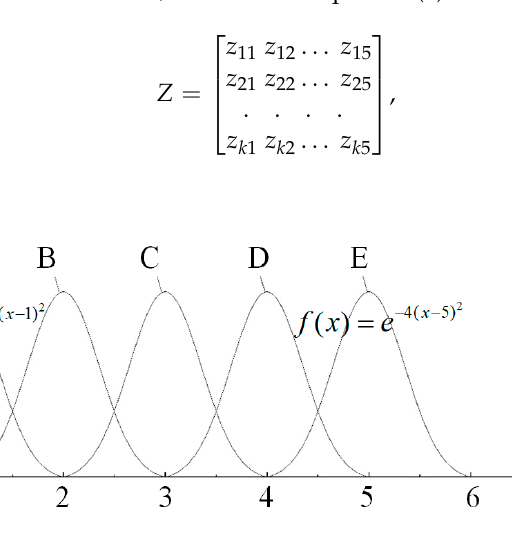
Figure 13. Membership function in the fuzzy mapping.